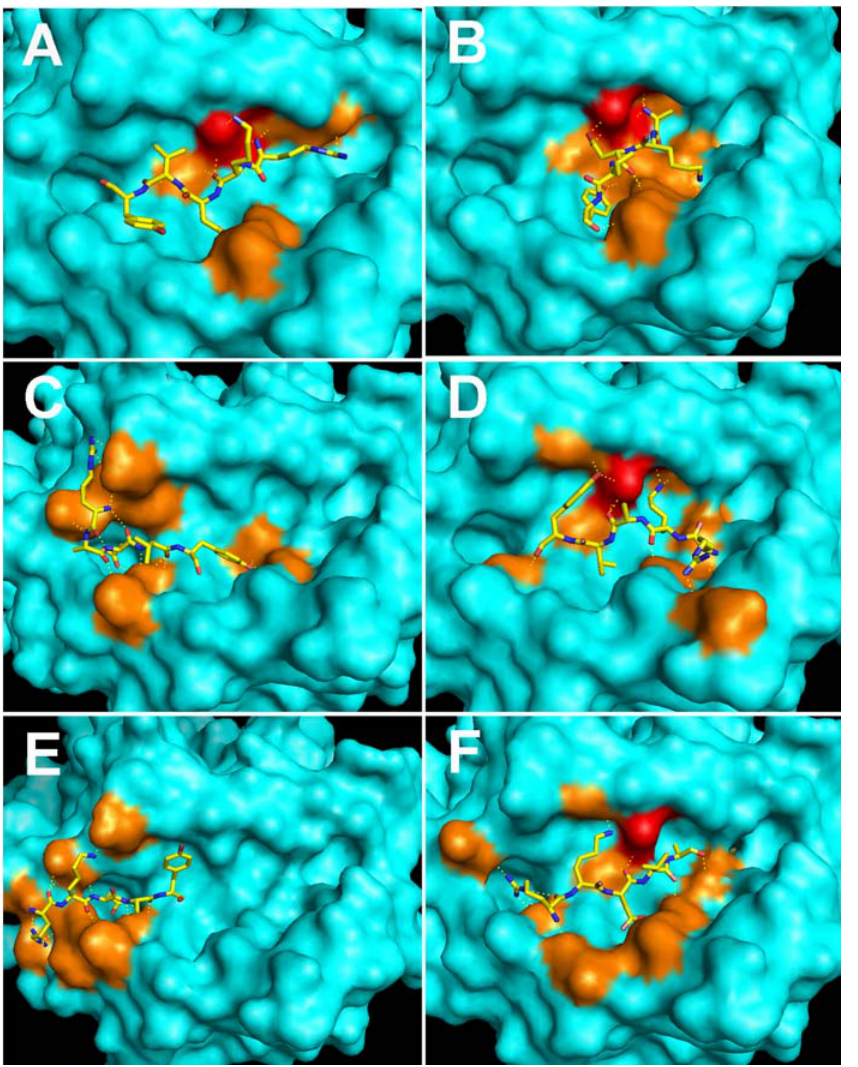
Figure 6. The predicted binding of TP5 and its alanine substitutions to HLA-DR. The key residues (E11, N62) are in red; the other contacted residues are in orange. Peptide variants correspond to A: RKDVY; B: A KDVY; C: R A DVY; D: RK A VY; E: RKD A Y; F: RKDV A .